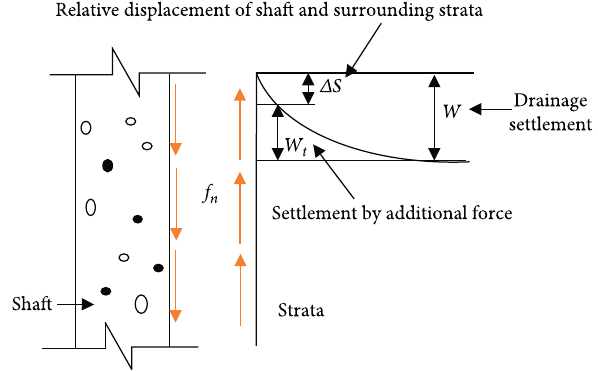
Figure 6: Reaction model of the additional force on the surrounding strata.